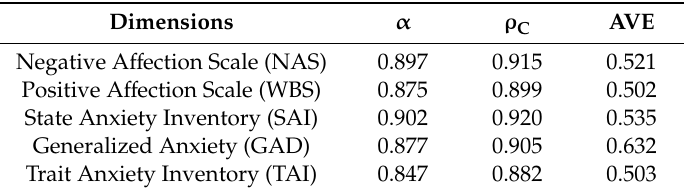
Table 6. Cronbach’s alpha ( α ), composite reliability ( ρ c ) and average variance extracted (AVE) for dimensions of the PANAS-GAD-7-IDATE